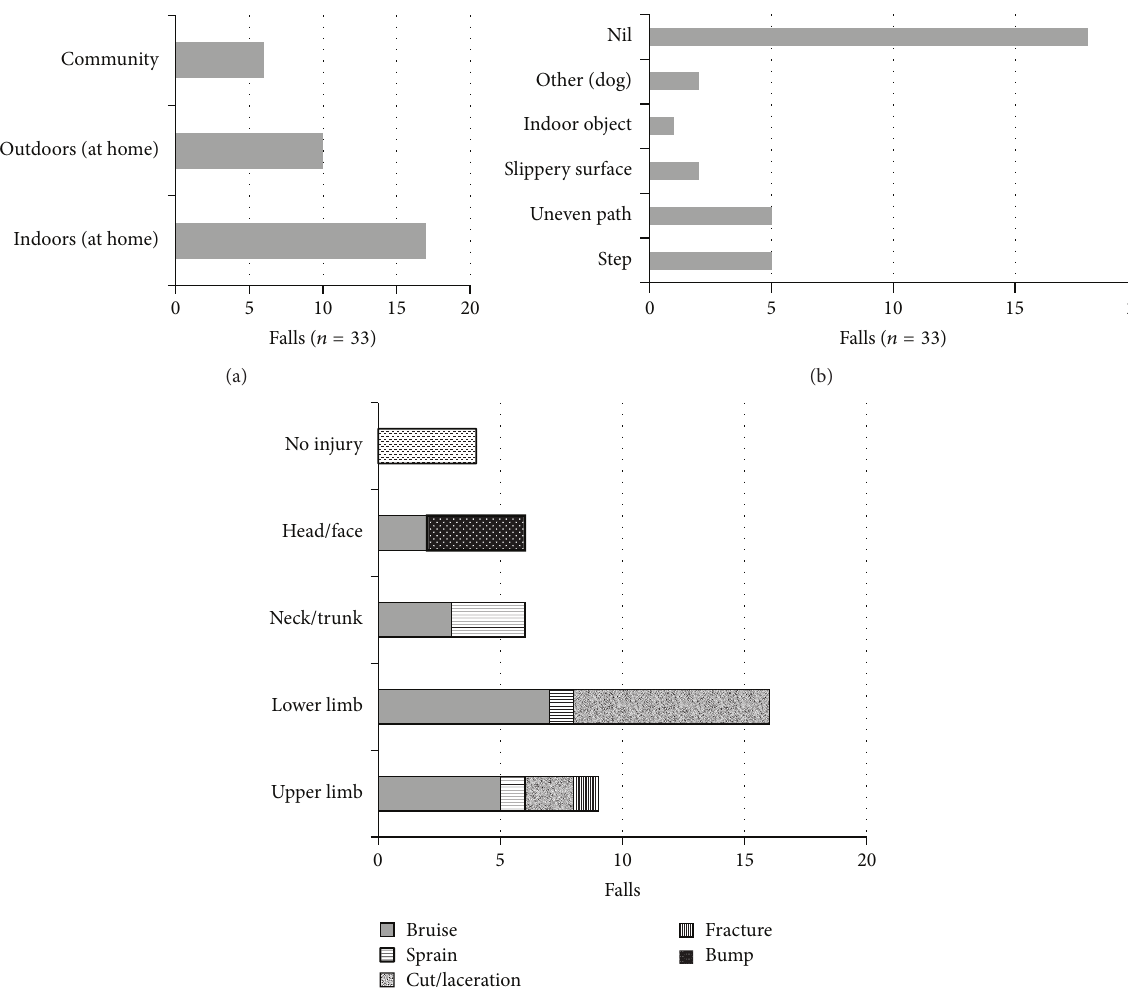
Figure 2: Location of most recent fall (a), obstacle involved in most recent fall (b), and consequence of most recent fall (c).